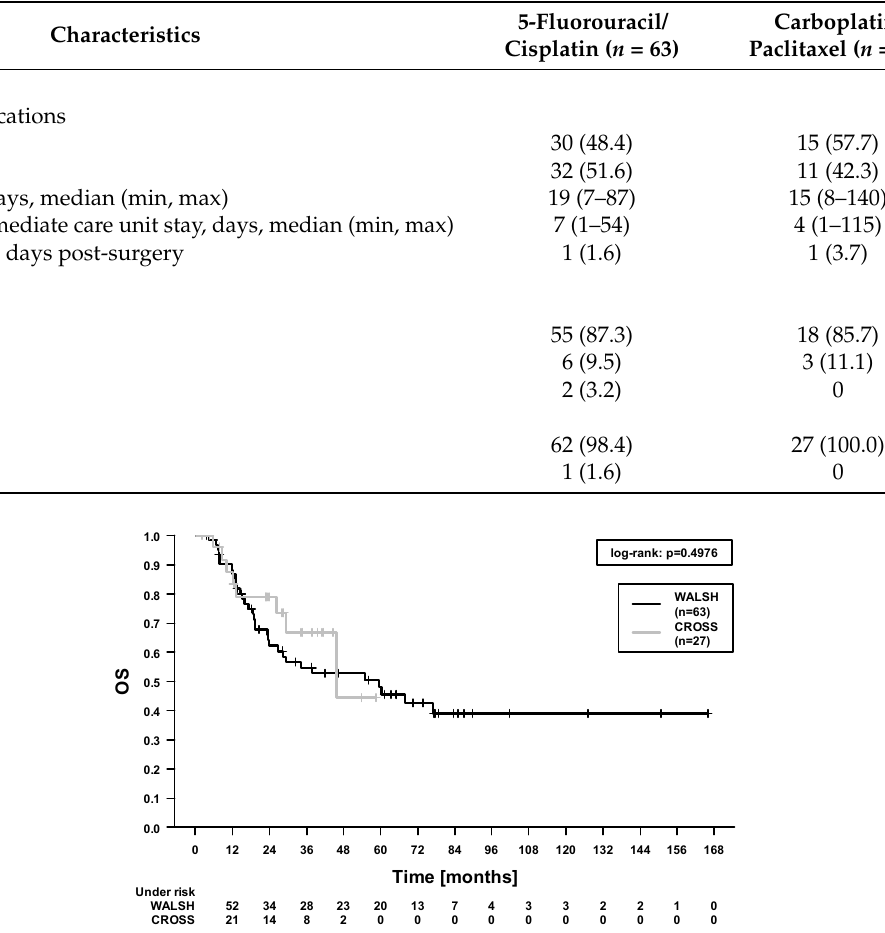
Table 3. Surgical outcomes and late toxicity. For each parameter, if not otherwise specified, the number of patients and, in brackets, the percentage are given. The statistical comparisons were performed using Chi-square test and Kruskal–Wallis test. Please note that the data for surgical complications are missing in 2 patients. Please see Supplemental Table S1 for a detailed list of surgical complications. The data for the hospital and intensive/intermediate care unit stay are missing for 9 patients. The data for late toxicity are missing for 6 patients.